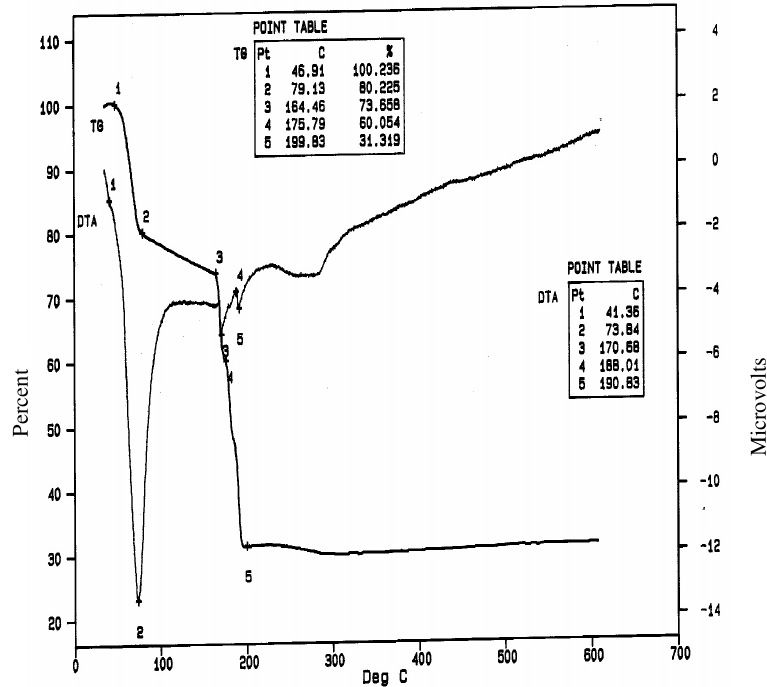
Figure 7. TG – DTA spectra of ZSHH